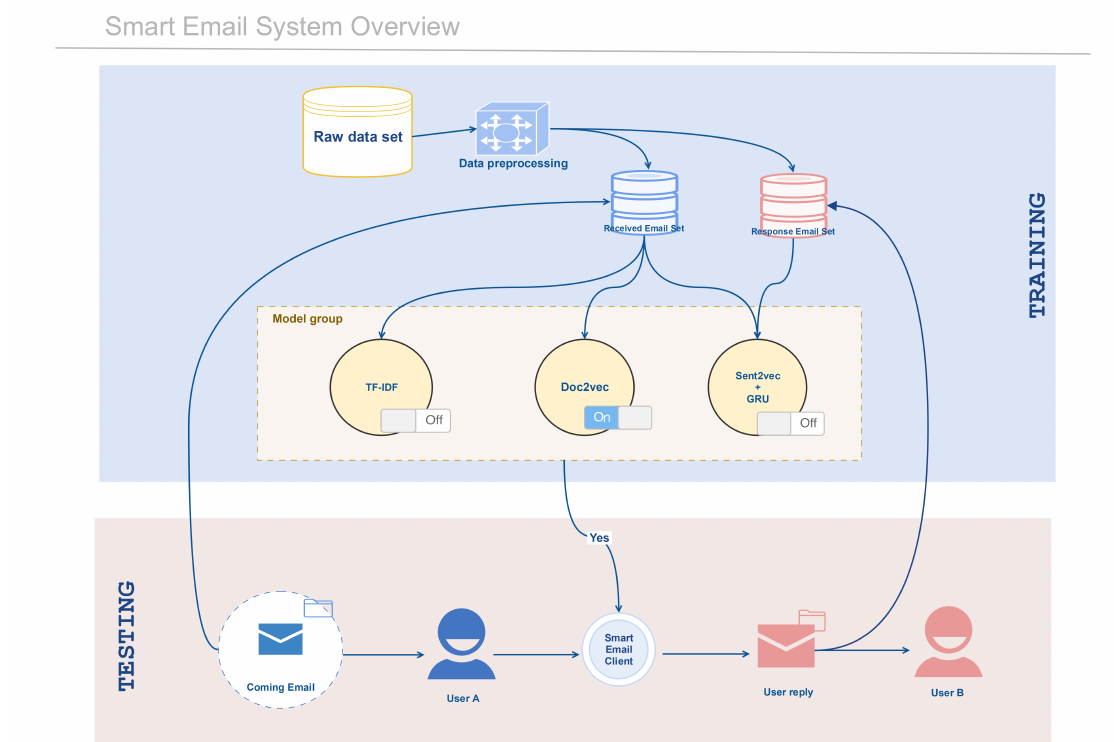
Figure 1. Smart Email Management System (SEMS)